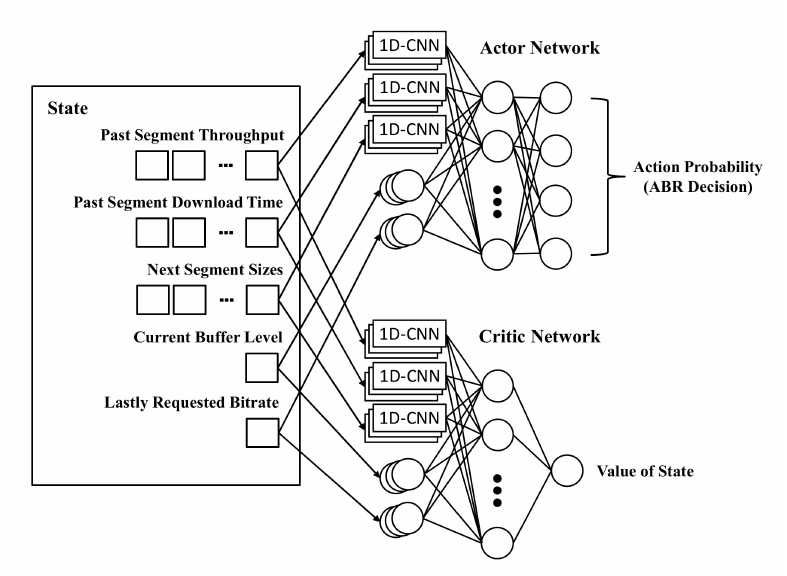
Figure 3. Architecture of actor network and critic network for generation of the